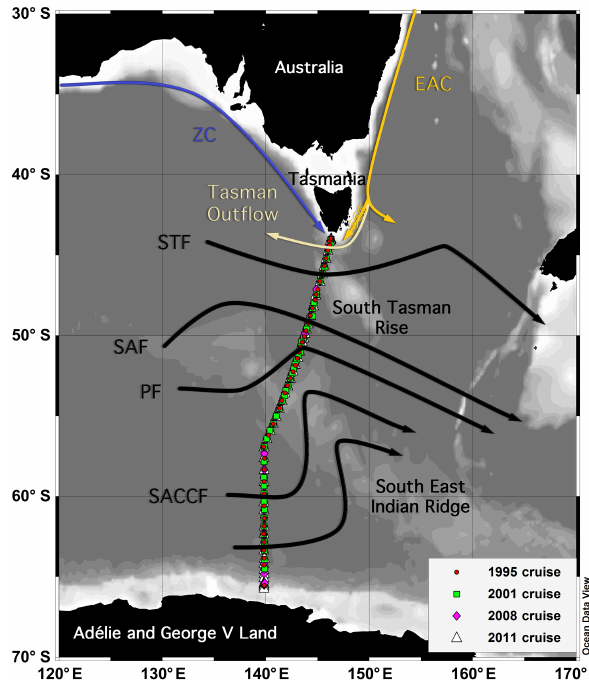
Figure 1. Transects of the four summer repeats of the G0-SHIP hydrodynamic line SR03 in the Southern Ocean south of Tasma- nia for the period 1995–2011 and the main hydrography features of the region. ZC = Zeehan Current. EAC = East Australian Current. Black arrows indicate the flow of the Antarctic Circumpolar Current (ACC), with STF = Subtropical Front; SAF = Sub-Antarctic Front, PF = Polar Front and SACCF = Southern ACC